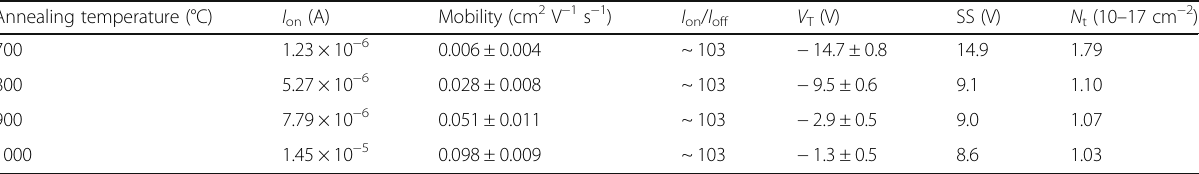
Table 1 Electrical parameters of CuAlO 2 TFTs with different annealing temperature Annealing temperature